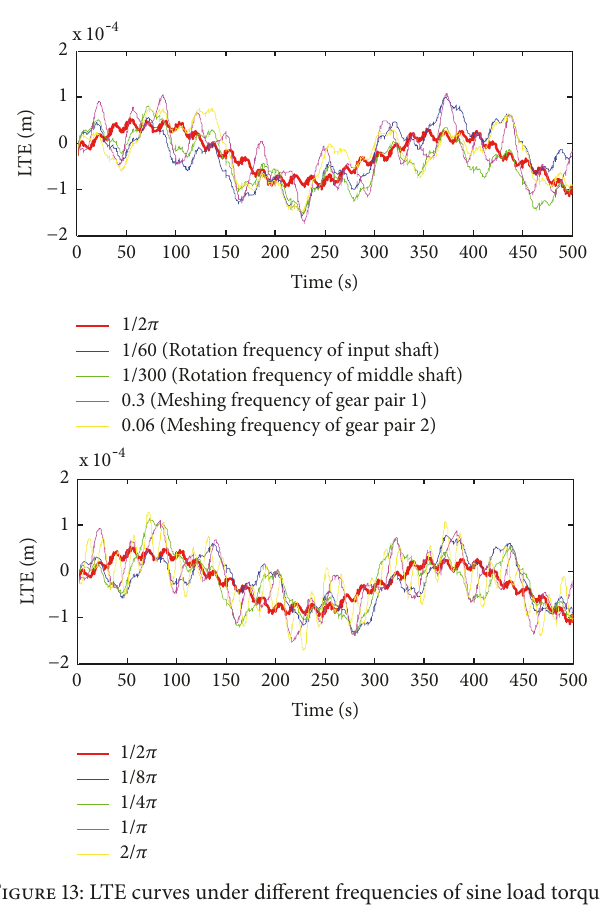
Figure 13: LTE curves under different frequencies of sine load torque.